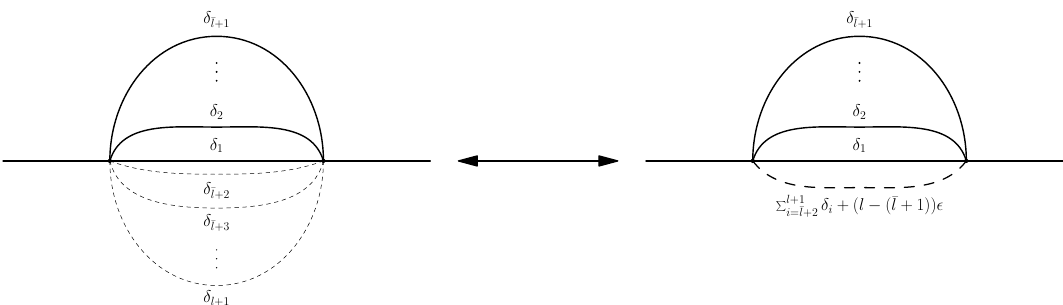
Figure 2 . Equivalence between a banana integral with several massless propagators and a single massless propagator with a modified